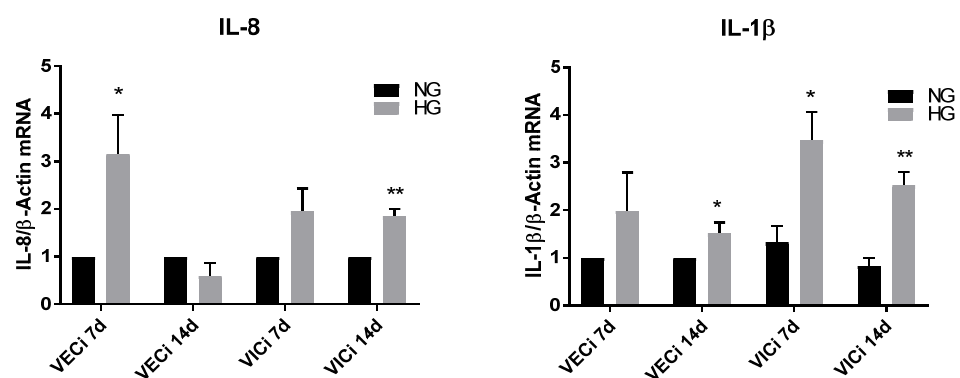
Figure 2. MCP-1, TNF- α , Il-8 and IL-1B gene expression in VIC and VEC isolated from 3D constructs based on gelatin, after 7 and 14 days of exposure to NG (5 mM glucose) or high glucose (HG, 5 mM glucose) conditions. The results are presented as fold change versus normal glucose (NG) condition for every type of cell and investigated time. N = 3, * p < 0.5, ** p < 0.01, *** p < 0.001.